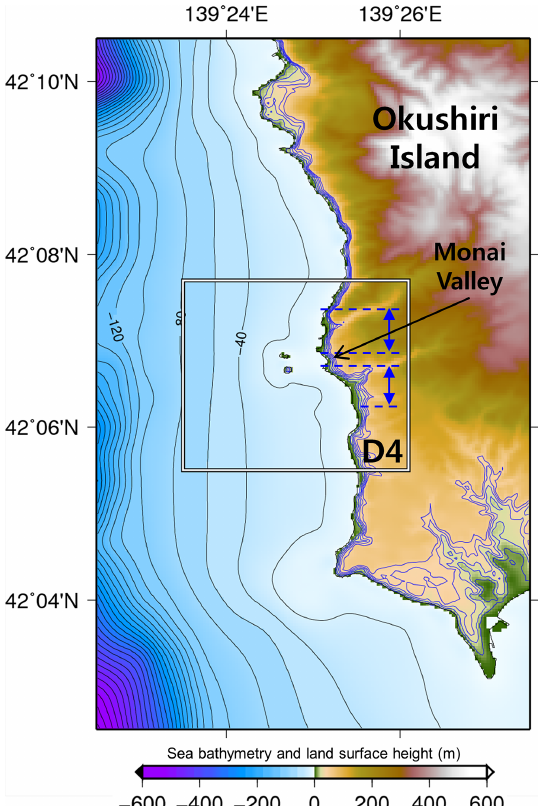
Figure 3. The bathymetry of the third domain (D3). The square box presents the fourth domain (D4) for the NH-model. The black solid lines of 20m intervals represent water depth, and the blue solid lines of 10m intervals represent the land heights up to 50m. The blue arrows indicate the regions where the mean run-up height value is calculated for the local amplification ratio.